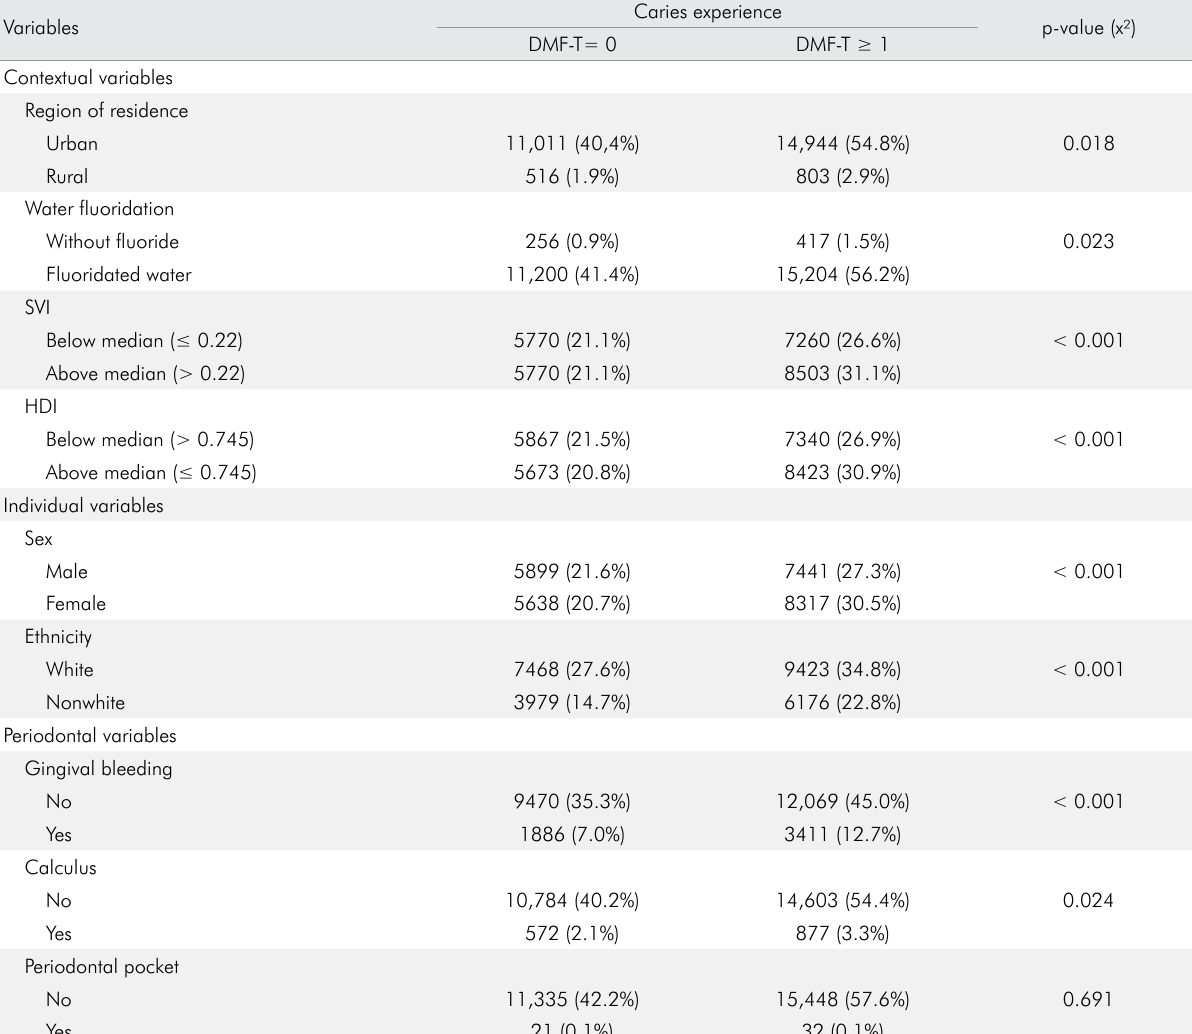
Table 1. Distribution of dental caries experience among 12-year-old children (n = 27,295), according to contextual, individual and periodontal